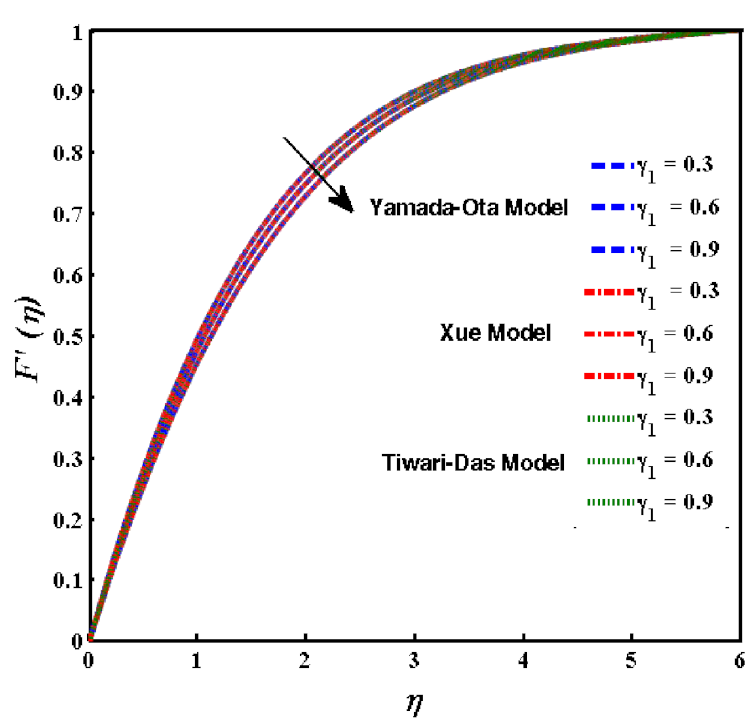
Figure 7. Influence of γ 1 on F (cid:48) ( η )